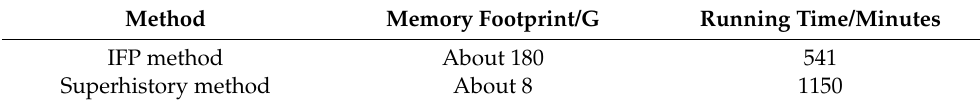
Table 6. Performance of the IFP method and the superhistory method in RMC.